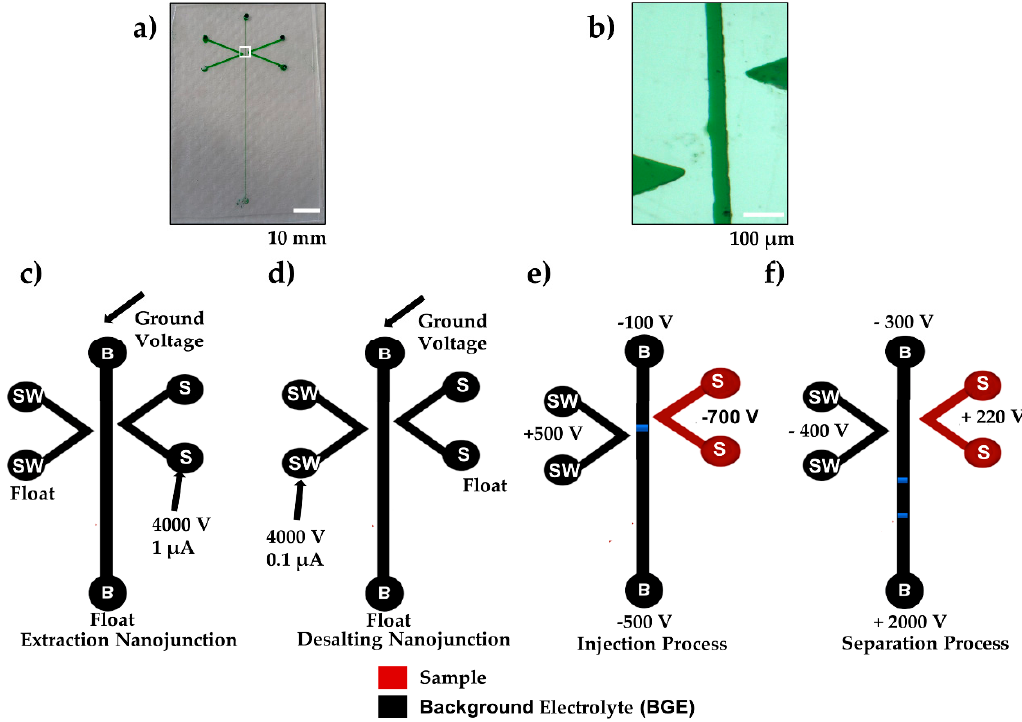
Figure 1. ( a ) Photograph image of the double-V hybrid PMMA/adhesive tape device filled with green food dye. Scale bar = 10 mm. ( b ) Zoomed in microscope image of the offset double-V channel filled with green food dye (white box in panel a). Scale Bar = 100 µm. ( c ) Schematic of the microfluidic device (dimension not to scale) indicating voltages and terminating current used for generation of the extraction nanojunction and ( d ) the desalting nanojunction. ( e ) Injection voltages (60 s) to extract, concentrate, and desalt injected plug (blue) of small molecules (ROX and fluorescein). ( f ) Separation voltages (180 s) for electrophoretic separation. Buffer (B), Buffer Waste (BW), Sample (S), and Sample Waste (SW).